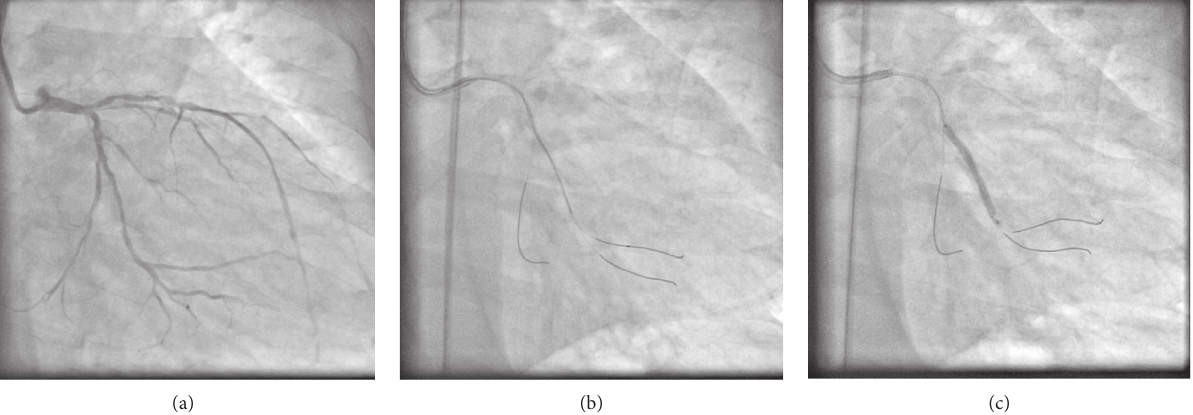
Figure 2: (a) RAO caudal view showing significant disease in LCX, OM, and LAD. (b) Metallic silhouette created by wiring the two branches of OM and distal LCX. (c) Stent positioned using the marker wires.